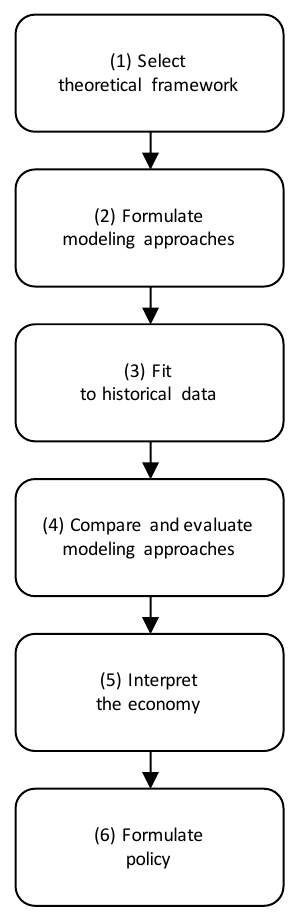
Figure 1. Theory to policy